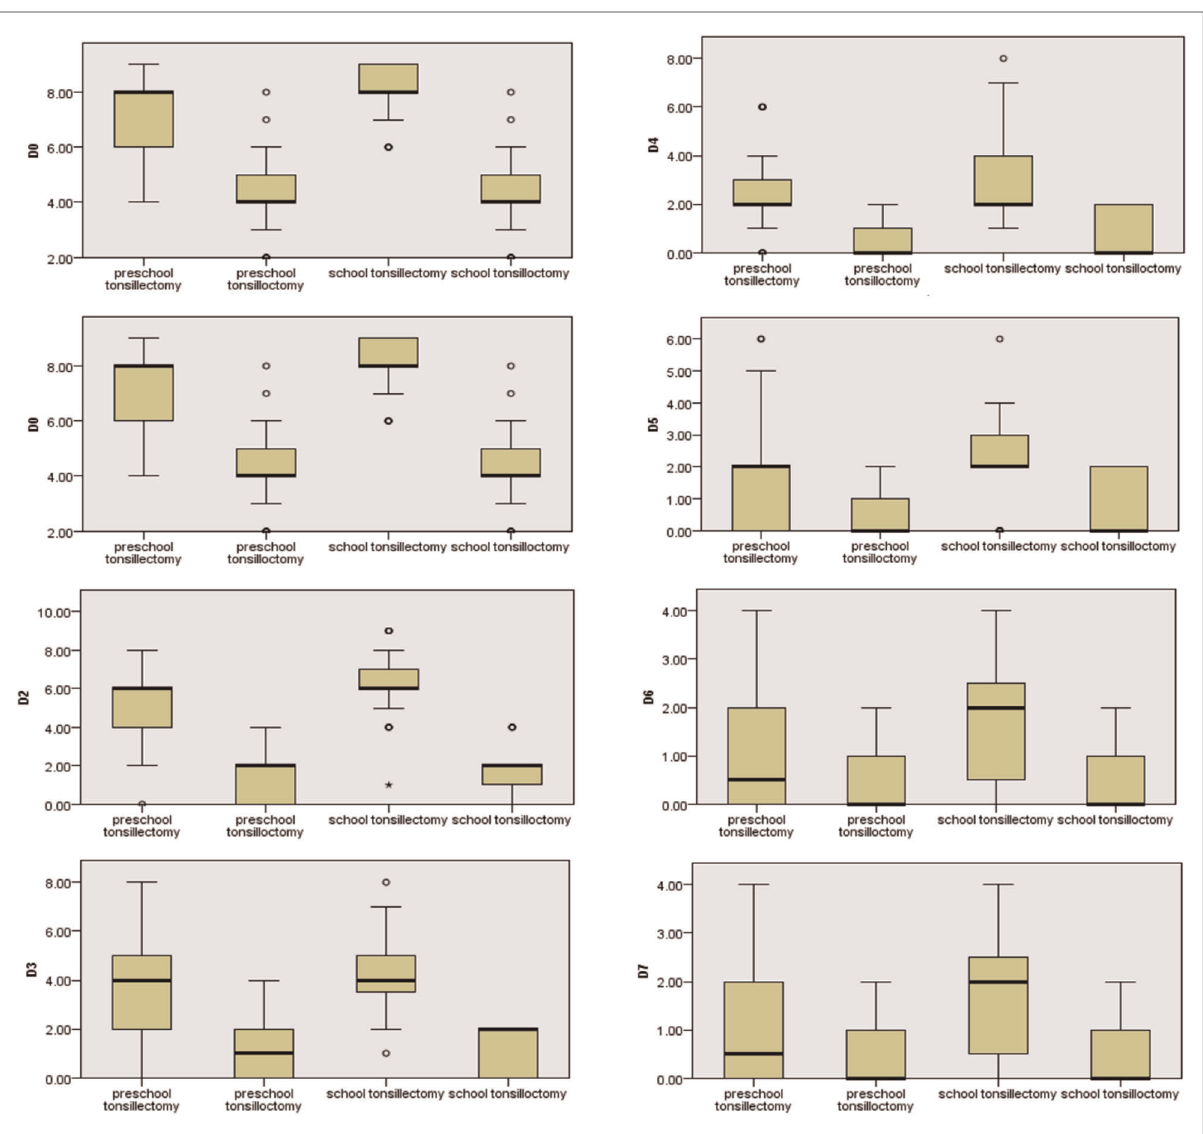
FIGURE 1 The comparison of pharyngeal pain (PPPM scores) among preschool-age tonsillotomy, preschool-age tonsilletomy, school-age tonsillotomy, and school-age tonsilletomy from D0 ∼